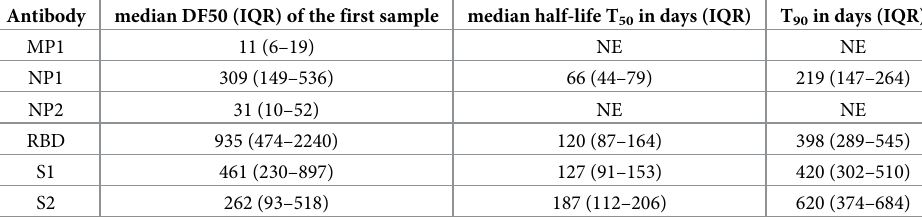
Summary of the decline dynamics for each antibody for the 20 naturally infected subjects. DF50 < 50 of the first sample corresponds to no or little reactivity. NE = Not Estimable because of low reactivity.